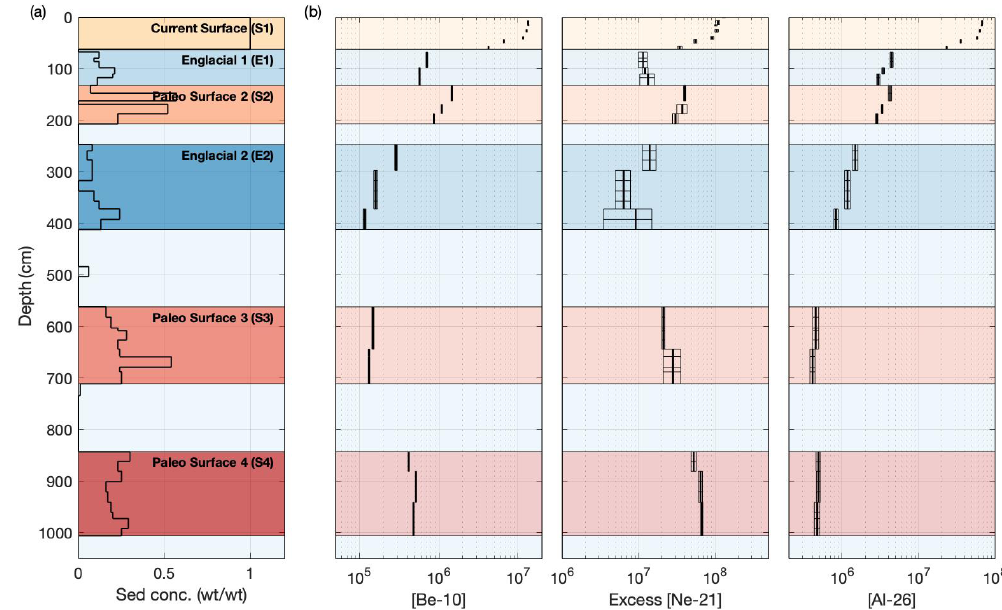
Figure 7. Depth plot of (a) sediment concentration (weight sediment/weight sediment and ice) and (b) measured 10 Be, 26 Al, and 21 Ne nuclide concentrations. The bold vertical lines represent the average measured cosmogenic nuclide concentrations in the samples. The width of the surrounding black boxes shows the measured uncertainty in the cosmogenic nuclide concentrations, and the horizontal black lines indicate the original ice core segments and are the same for all three nuclides. Color shades highlight the source of the debris. Yellow depicts the current supraglacial debris samples (S1) and has same origin as blue samples (E1 and E2) identified as “englacial debris” having no prior surface exposure before being subglacially entrained. Samples in shades of red are identified as “paleo-surfaces” (S2, S3, and S4) and are made of recycled surface debris that was exposed on the surface and entrained as the glacier overrode previously ice-free areas as it advanced into Ong